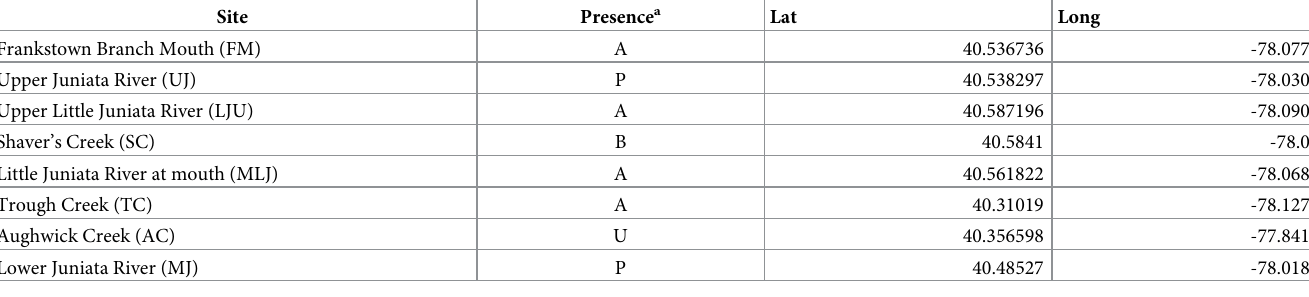
Table 1. Sampling sites for eDNA assay in the Juniata River watershed, Pennsylvania.